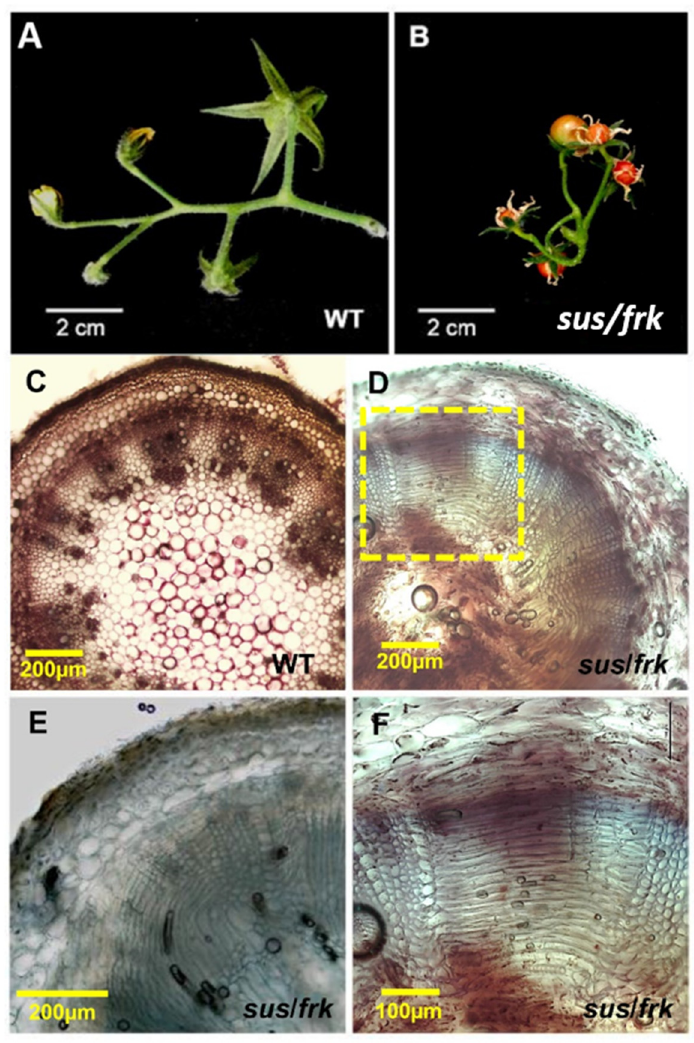
Figure 7. The sus / frk line exhibited distinct inflorescence architecture and disturbed directionality of xylem and parenchyma cells. ( A ) WT inflorescence. ( B ) sus / frk inflorescence exhibiting altered peduncle phyllotaxis. ( C ) Cross-section of a WT peduncle. ( D , E ) Cross-section of a sus / frk peduncle in which the orientation of the parenchyma xylem cells was disturbed. ( F ) Enlargement of the xylem area is indicated by the yellow box in ( D ).